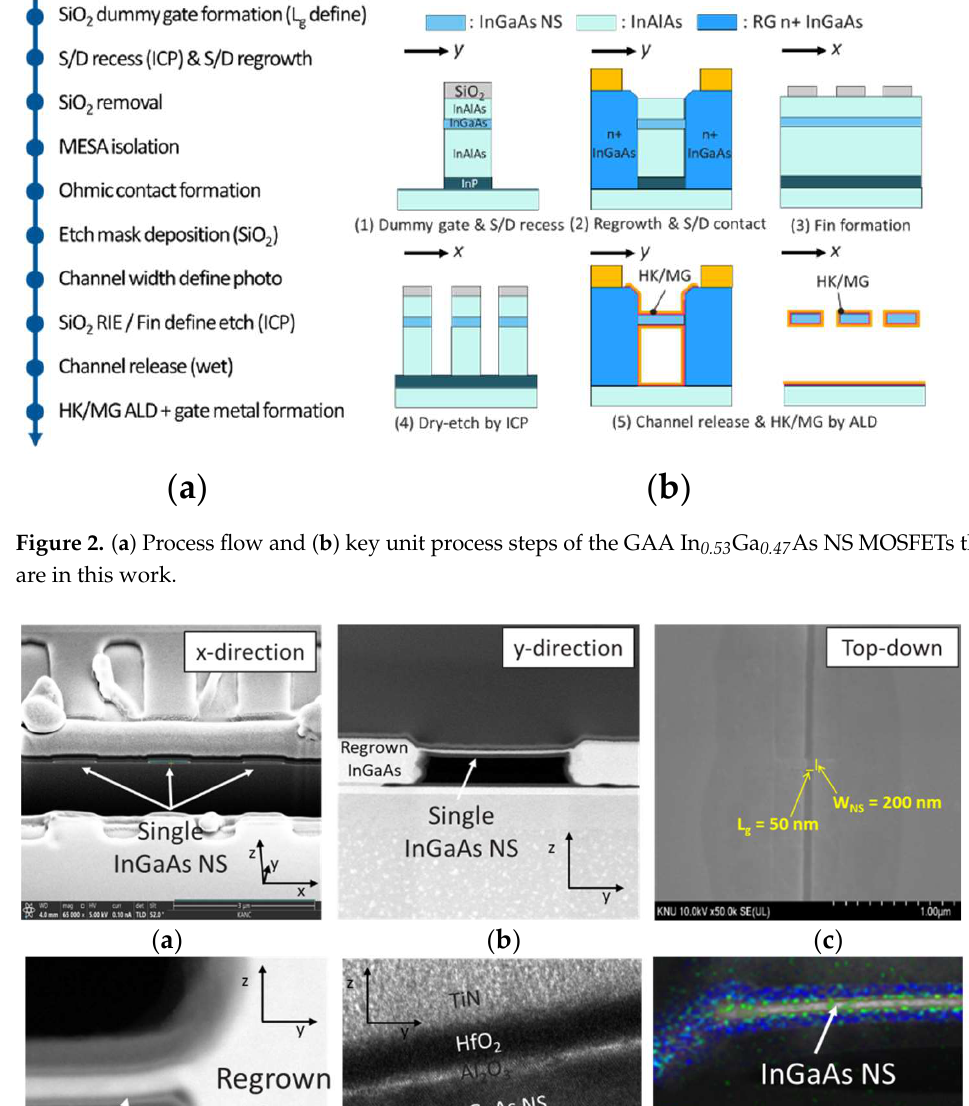
Figure 3. Cross-sectional and top-down TEM/SEM images of the fabricated GAA In 0.53 Ga 0.47 As NS MOSFETs along the W g ( x -direction, ( a )) and S/D ( y -direction, ( b – e )) directions, and EDS mapping data ( f ). 3. Results and Discussion Figure 4 exhibits two types of transmission line method (TLM) test structures: one TLM structure was used to evaluate the sheet resistance of the regrown n+ InGaAs layer ( R RG_sh ) and the contact resistance ( R c ) between the non-alloyed ohmic of a Ti/Mo/Ti/Pt/Au metal stack and the regrown n+ In 0.53 Ga 0.47 As layer (Figure 4a), and the other TLM struc- ture was used to evaluate the actual source resistance ( R s ) for the fabricated GAA In 0.53 Ga 0.47 As NS MOSFET (Figure 4b) with a dimension of L GS = 0.5 m. The TLM structure shown in Figure 4b was effective in characterizing the regrown contact resistance of R c-NS . Here, R c-NS stands for a contact resistance between the regrown n+ In 0.53 Ga 0.47 As layer and